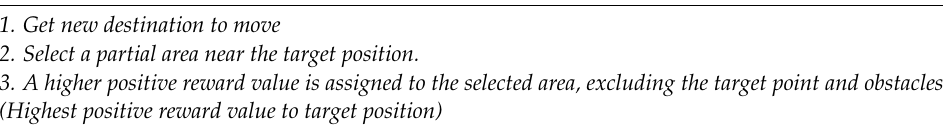
Algorithm 3: Dynamic reward adjustment based on action.